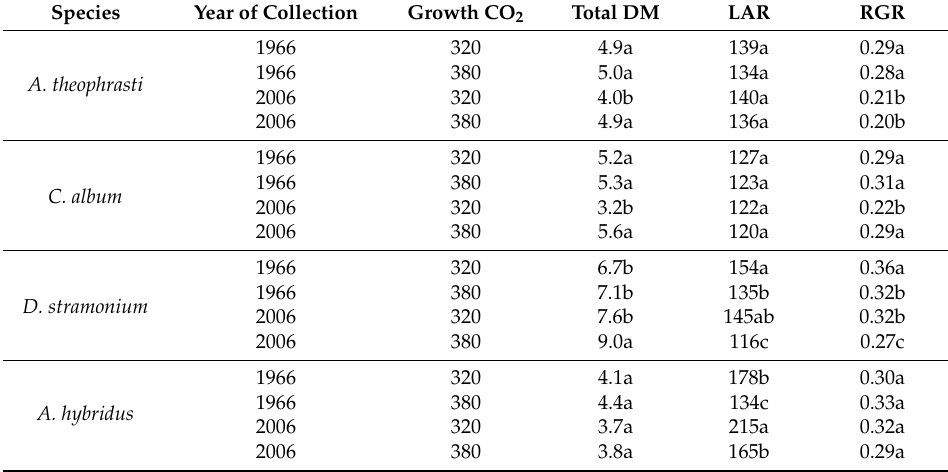
Table 1. Seedling dry mass production for seed lots of four species collected in 1966 and 2006,